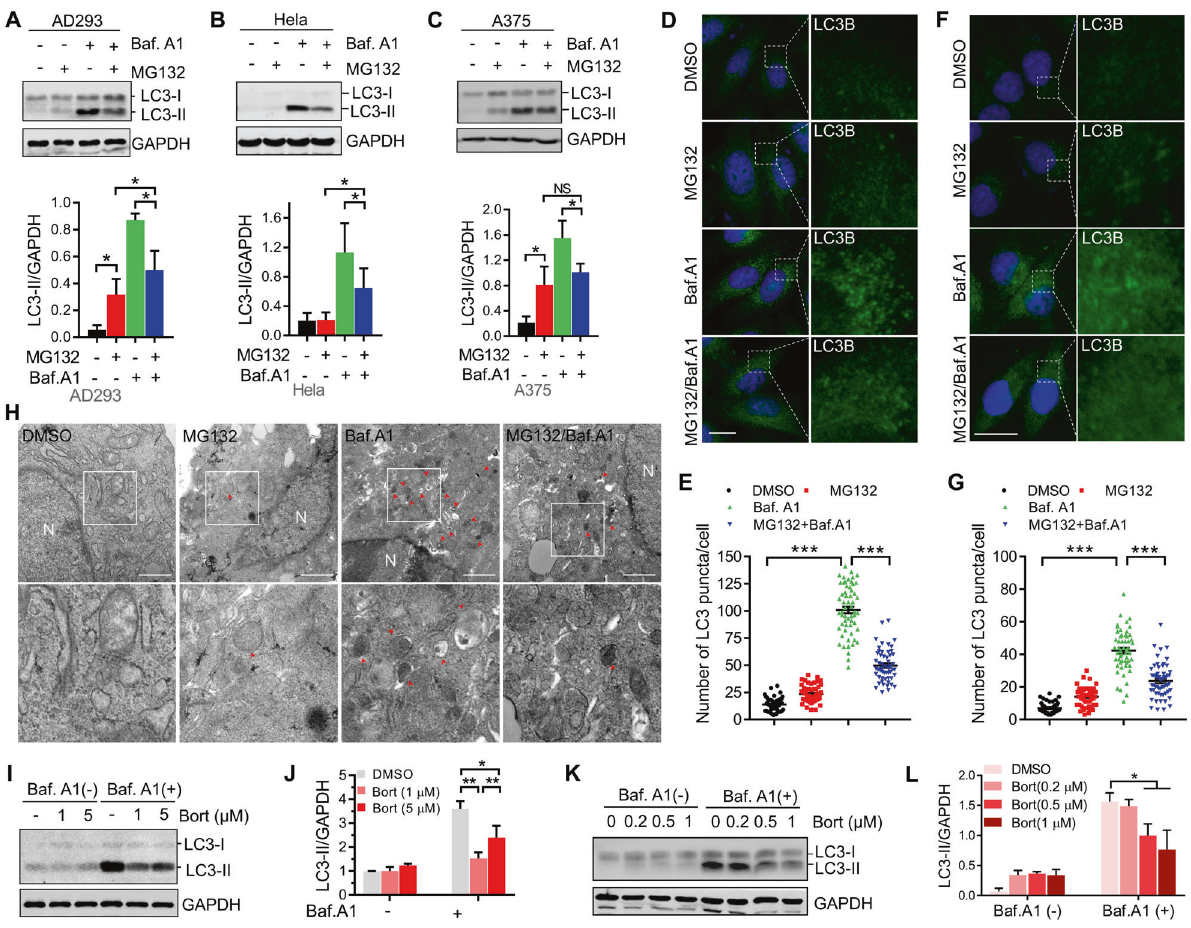
Fig. 1 Suppressing autophagosome formation is the early response of cells to proteasome inhibition. A – C AD293, HeLa and A375 cells were treated with DMSO (control), or MG132 (2 μ M), and Ba fi lomycin A1 (25 nM), alone or in combination for 14 h. The whole-cell lysates were subjected to western blot analysis with indicated antibodies. D HeLa cells were treated with DMSO (control), or MG132 (1 μ M), and Ba fi lomycin A1 (25 nM), alone or in combination for 14 h. The LC3B-positive autophagosomes were analyzed by confocal microscopy. Scale bar: 10 μ m. E Quantitative analysis of the results in ( D ). F A375 cells were treated with DMSO (control), or MG132 (2 μ M), and Ba fi lomycin A1 (25 nM), alone or in combination for 14 h. The LC3B-positive autophagosomes were analyzed by confocal microscopy. Scale bar: 10 μ m. G Quantitative analysis of the results in ( F ). H Representative electron micrographs from A375 cells treated with DMSO (control), or MG132 (2 μ M), and Ba fi lomycin A1 (25 nM), alone or in combination for 14 h. N, nucleus; Arrows, autophagosomes or autolysosomes; Scale bar: 1 μ m. I HeLa cells were treated with Bortezomib at indicated concentrations with or without 25 nM Ba fi lomycin A1 for 14 h, and then the whole-cell lysates were subjected to western blot analysis with indicated antibodies. J Quantitative analysis of the results in ( I ). K A375 cells were treated with Bortezomib at indicated concentrations with or without 25 nM Ba fi lomycin A1 for 14 h, and then the whole-cell lysates were subjected to western blot analysis with indicated antibodies. L Quantitative analysis of the results in ( K ). For A , B , C , J , and L , data are mean ± SEM of